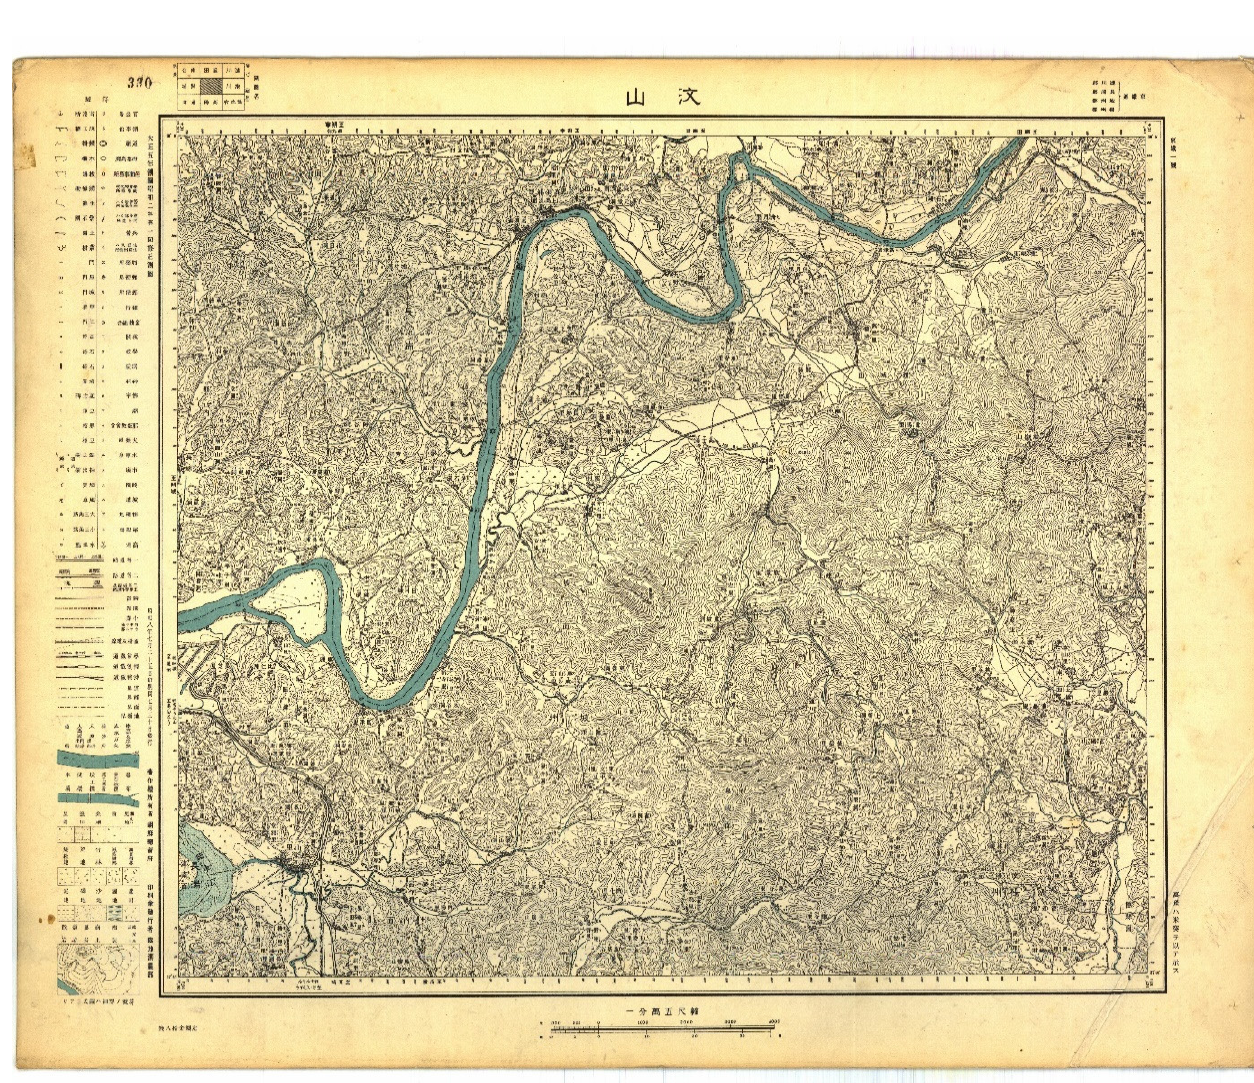
Figure A3. Old map drawn during the Japanese colonial era (1919).